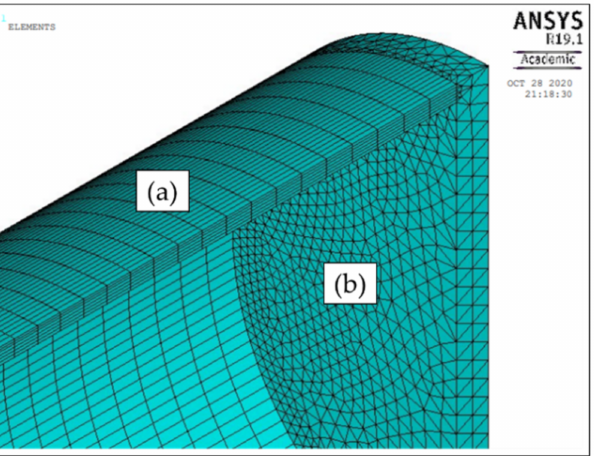
Figure 2. ( a ) Hexahedral SOLID185 elements used to mesh the pipe body and defect region, and ( b ) tetrahedral SOLID186 elements used to mesh the